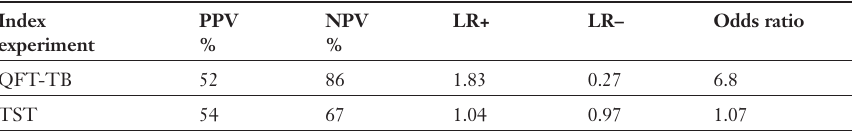
Diagnostic confidence for QFT-TB